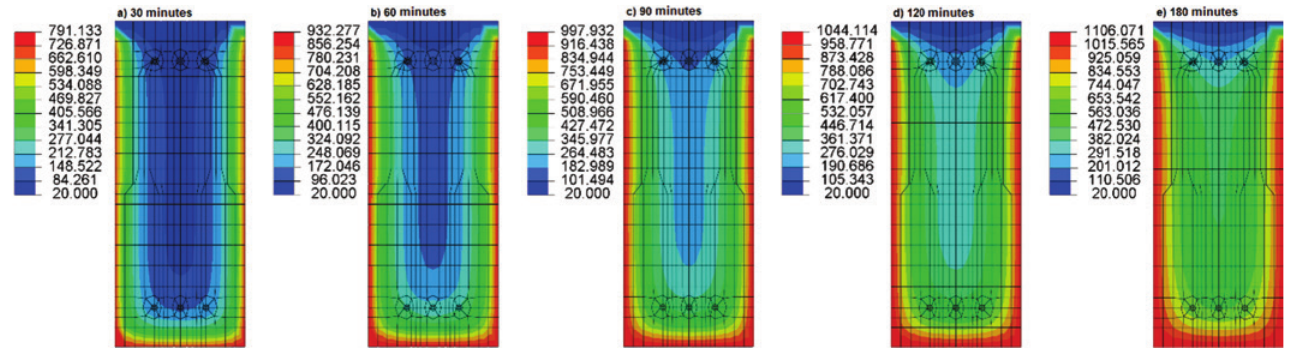
Figure 10 Isotherm B2-IV for ratings of (a) 30, (b) 60, (c) 90, (d) 120, and (e) 180